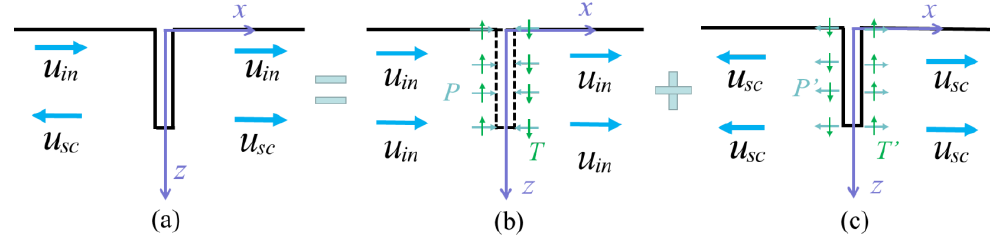
Figure 2. Schematic diagram of scattering wave superposition principle of surface crack: ( a ) total field of incident wave and scattered wave; ( b ) incident wave field and its resultant tractions; ( c ) crack under tractions and corresponding scattered wave field.